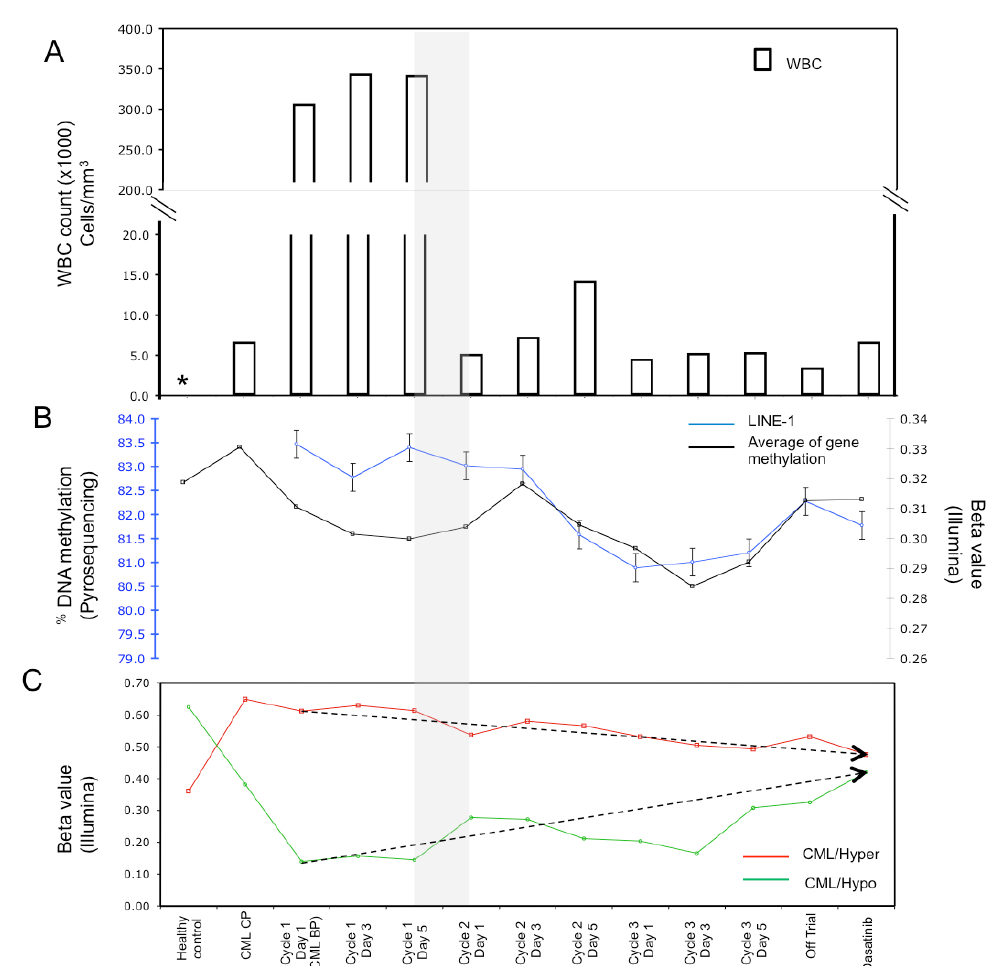
Figure 6: Clinical response and DNA methylation changes induced by azacitidine (Vidaza ® ) treatment in a patient with CML. A) WBC count, B) DNA methylation of the LINE-1 repetitive element, and the mean DNA methylation of 1,007 CpG sites for Illumina GoldenGate analysis, and C) CML progression hyper- and hypomethylated loci following a course of azacitidine